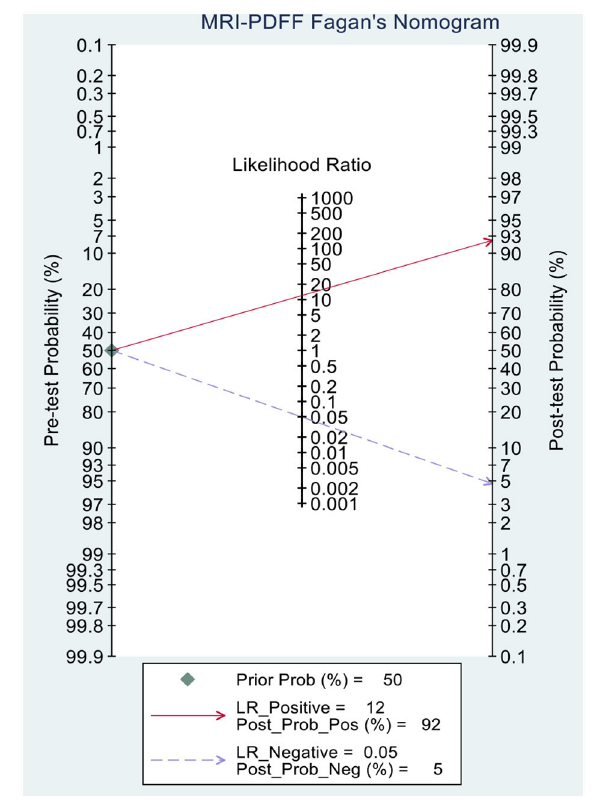
FIGURE 4 | Fagan plot analysis to evaluate the clinical utility of MRI-PDFF and TE-CAP (S0 vs.